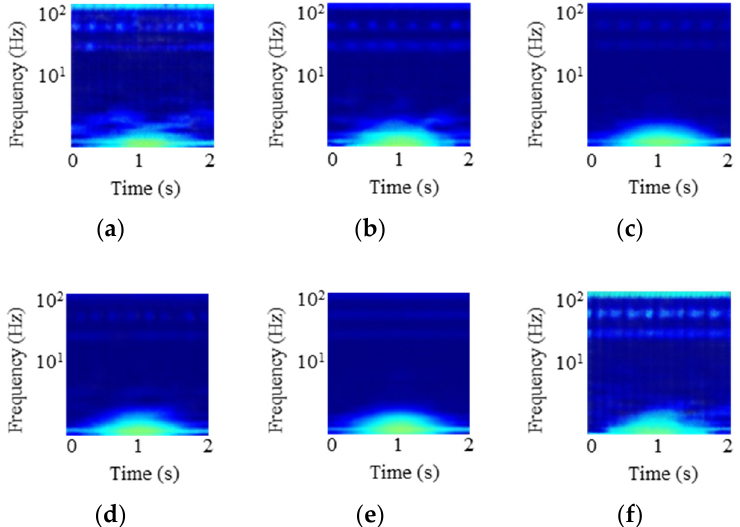
Figure 11. Fake time-frequency images generated by GAN: ( a ) 1 external broken wire; ( b ) 2 external broken wires; ( c ) 3 external broken wires; ( d ) 1 internal broken wire; ( e ) 2 internal broken wires; ( f ) 3 internal broken